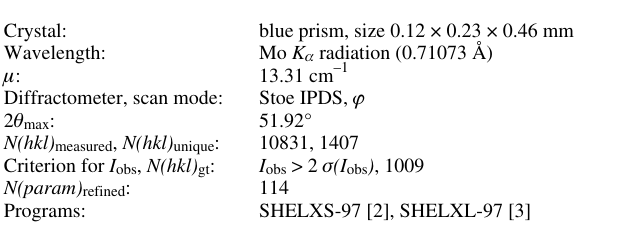
Table 1. Data collection and handling.